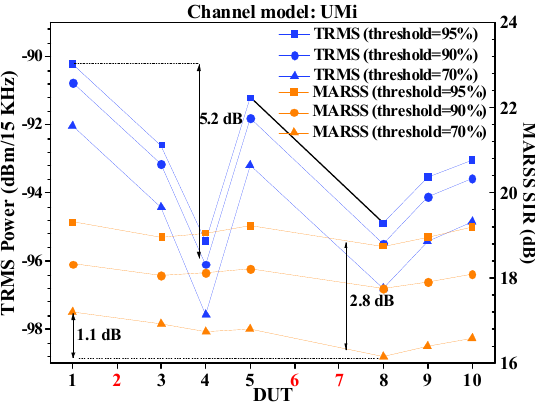
Figure 6. A comparison between TRMS and MARSS for the UMa channel model.